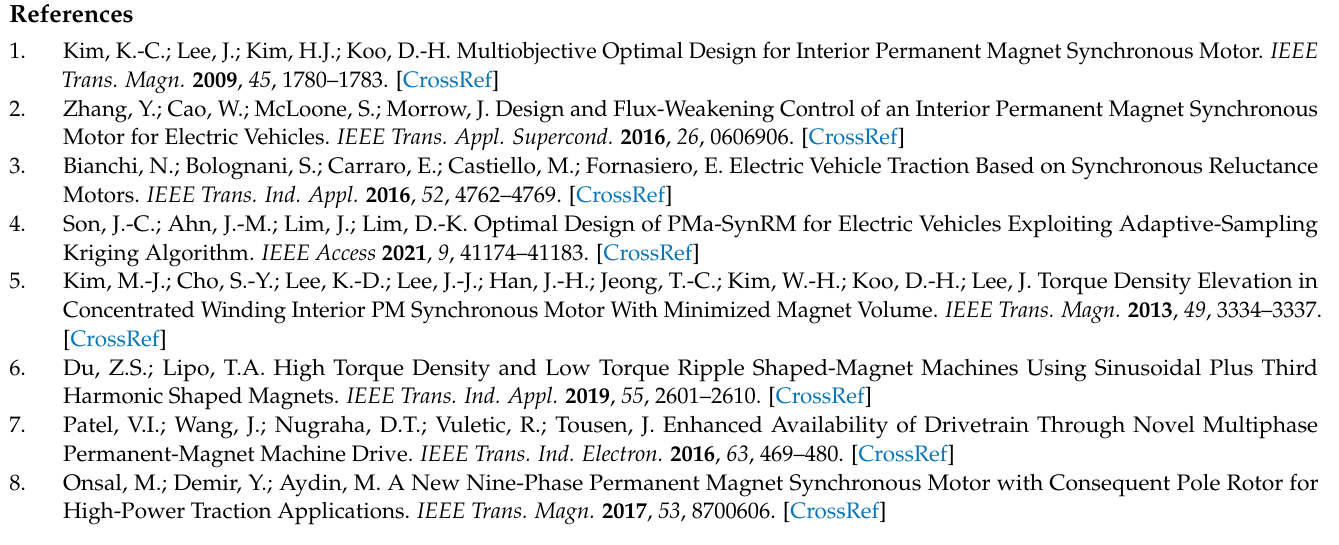
Figure A1. Meshing illustration: ( a ) FI-PMa-SynRM; ( b ) Inset SPMSM model; ( c ) SynRM model; ( d ) Modified SynRM.